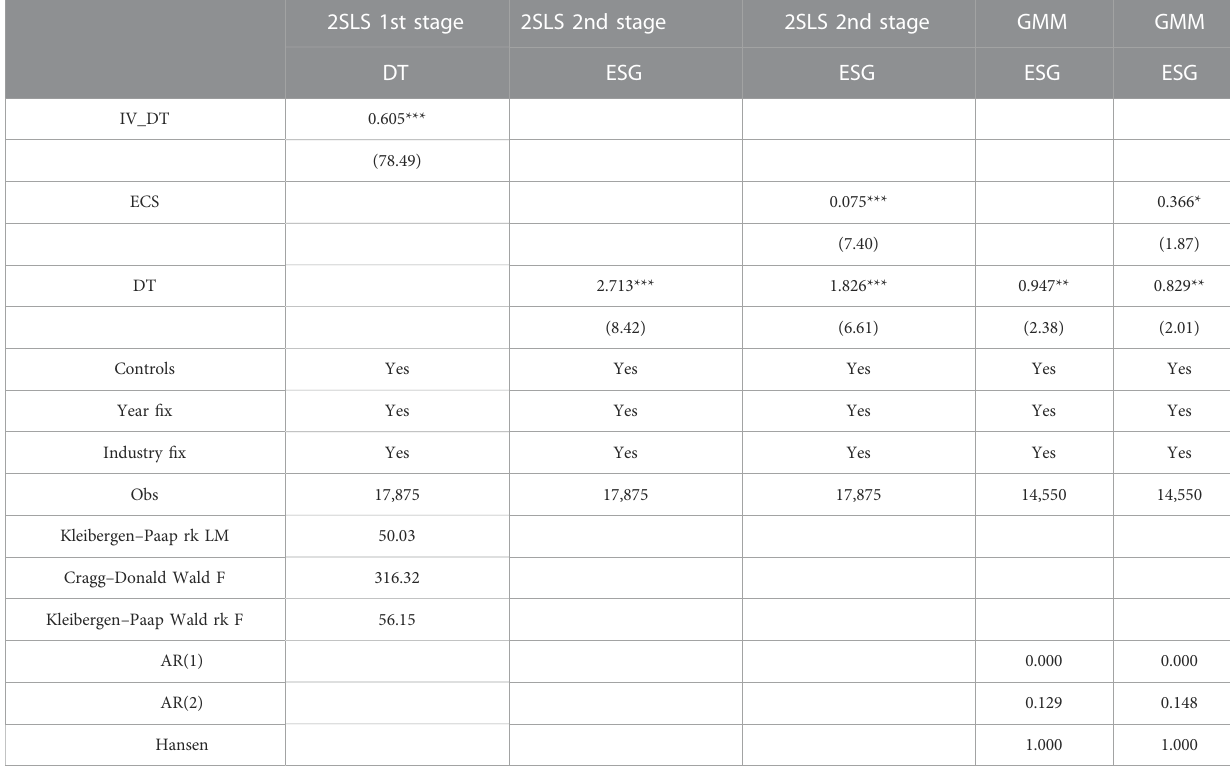
TABLE 8 GMM and 2SLS